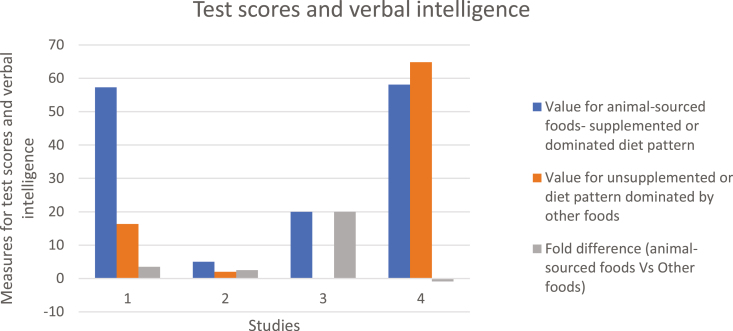
Comparison of test scores and verbal intelligence between subjects supplemented with animal-sourced foods or have animal-sourced foods-dominated diet patterns and subjects supplemented or with diet patterns dominated by other foods. Results are from four studies; 1: (Hulett et al., 2014), 2 and 3: (Neumann et al, 2007), 5: (Mohammed & Aboud, 2019). Nine measures of cognitive development summarized include 1: Combined test scores (Arithmetic, English, Kiembu, Kiswahili, Geography, Sciences and Art); 2: End-of-term arithmetic scores (Raven’s progressive Matrices test); 3: End -of-term total test scores over time (Raven’s Progressive Matrices test); 4: Adjusted mean scores in mathematics and English)